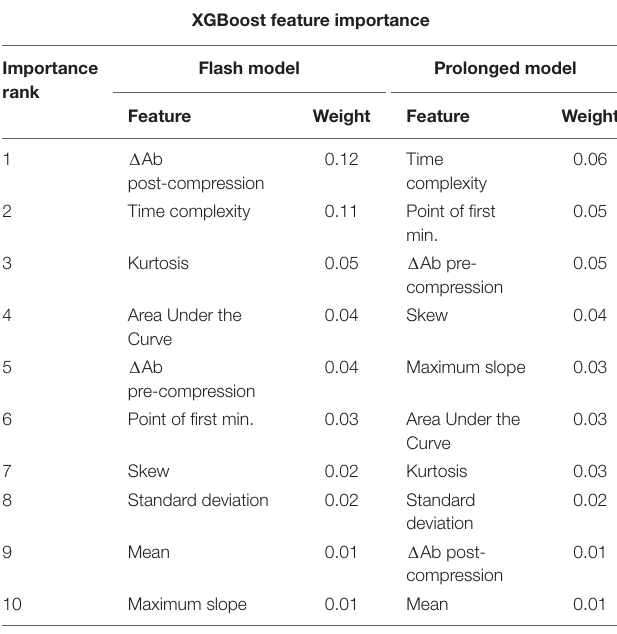
TABLE 3 | Feature importance analysis for XGBoost flash and prolonged capillary refill time